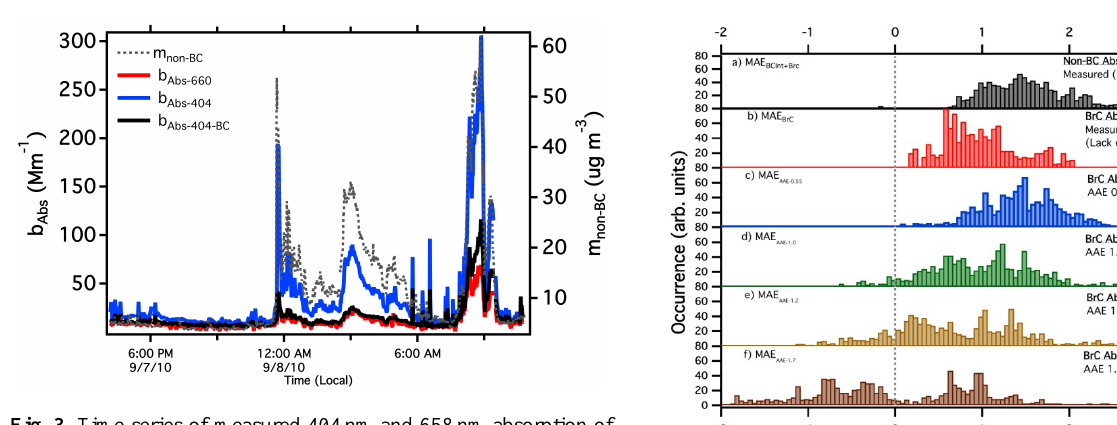
Fig. 3. Time series of measured 404nm and 658nm absorption of ambient particles (blue and red lines), 404nm thermo-denuded ab- sorption (black) and non-refractory aerosol mass (dashed grey line).